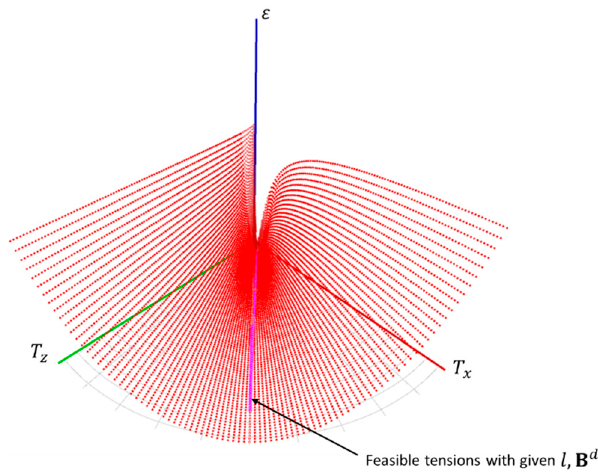
> 0. max 0 ε > . Figure 3. The feasible tensions T with given L , B max